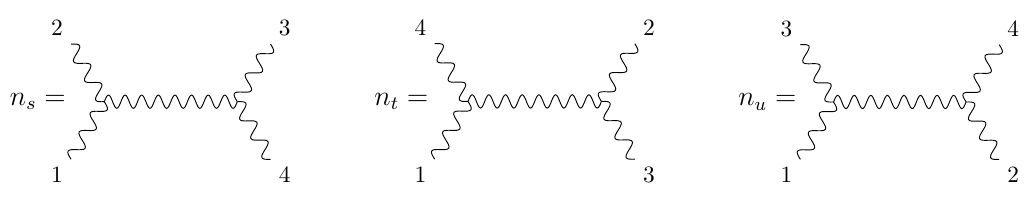
Figure 1 . The three numerator structures for the color-dressed amplitude. Two of these appear in each color-ordered